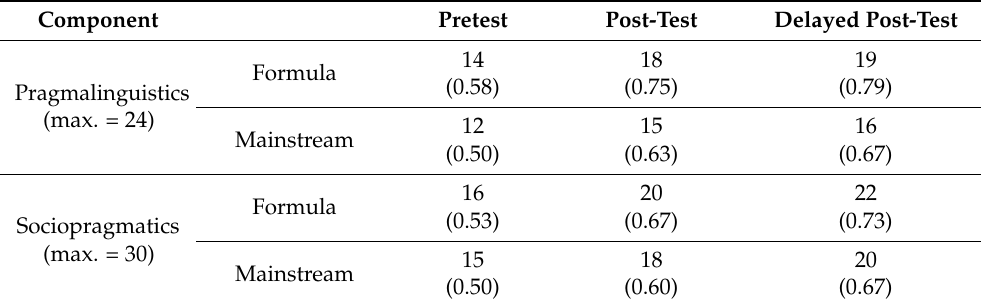
Table 3. Average median scores across four speech acts for Formula and Mainstream groups: Percent- ages in